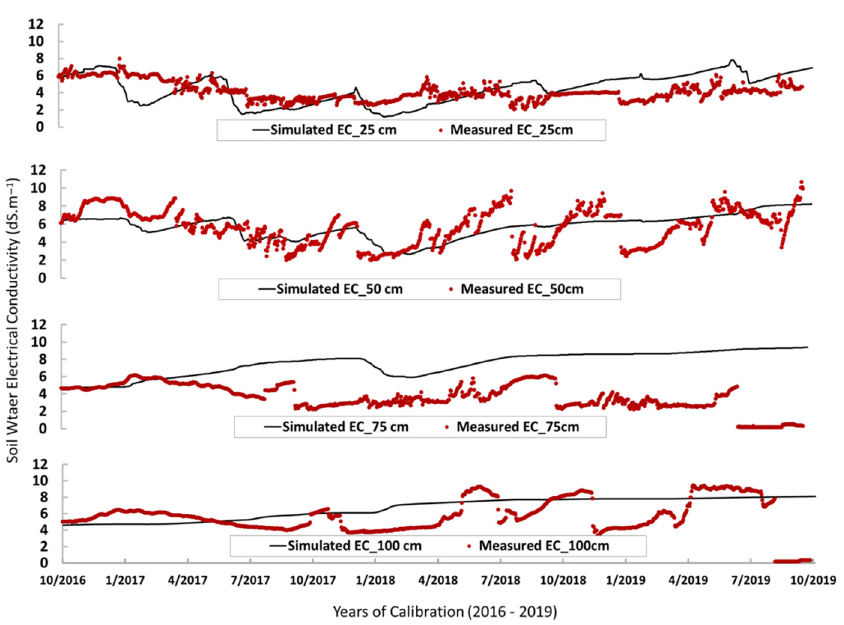
Figure 9. Measured (dots) and simulated (lines) electrical conductivities at four observation depths of 25, 50, 75, and 100 cm at the ASH site.